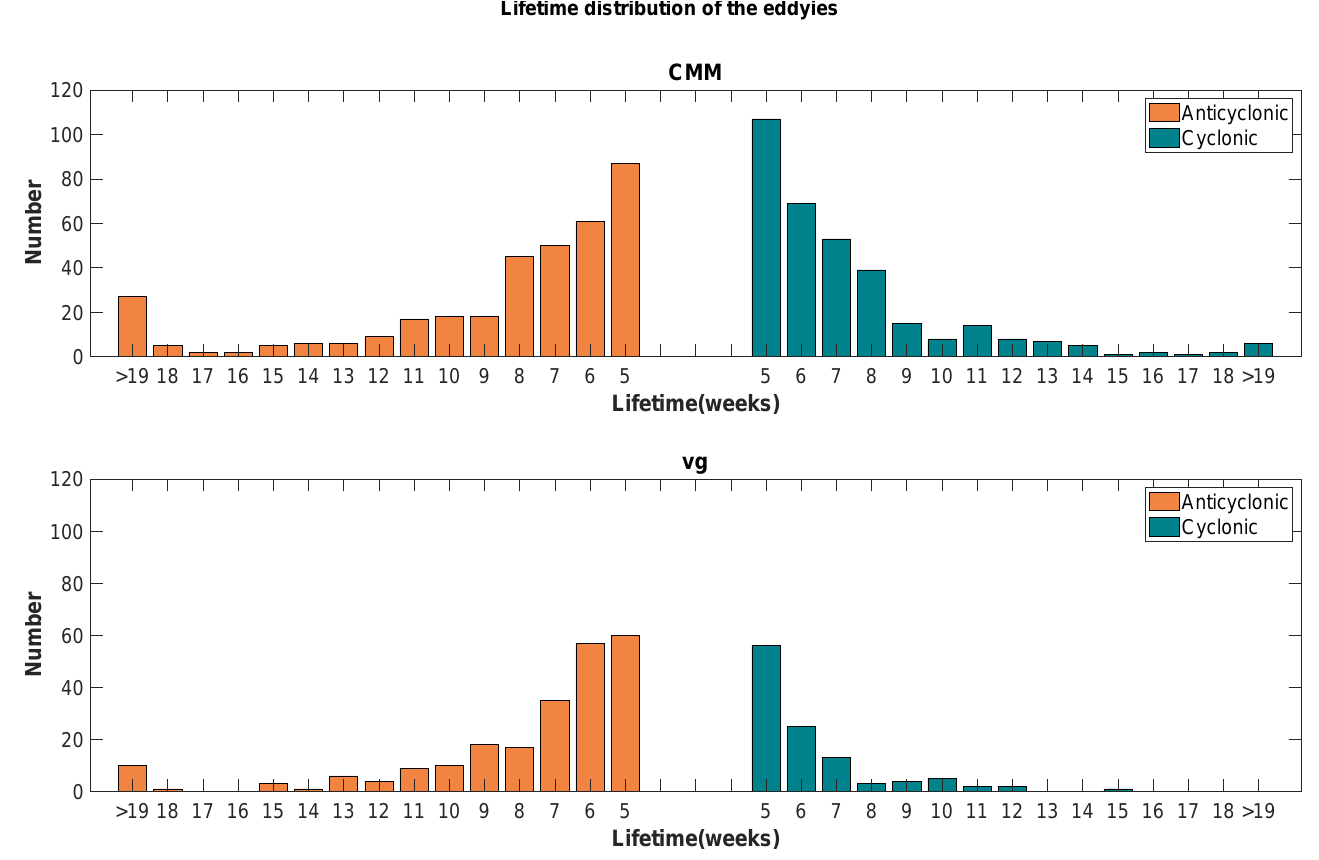
Figure 8. Lifetime distribution of the eddies detected by the two methods in the BSs during 2011–2020 (for eddies with a lifetime > 4 weeks). The upper panel is the lifetime distribution found with the CMM method. The bottom panel is the lifetime distribution found with the VG